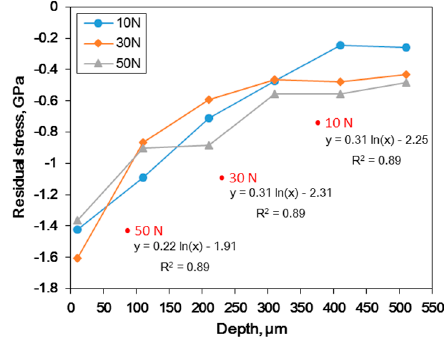
Figure 10. The e ff ect of the static load in UNSM treatment on the residual stress depth profile of Alloy 600.